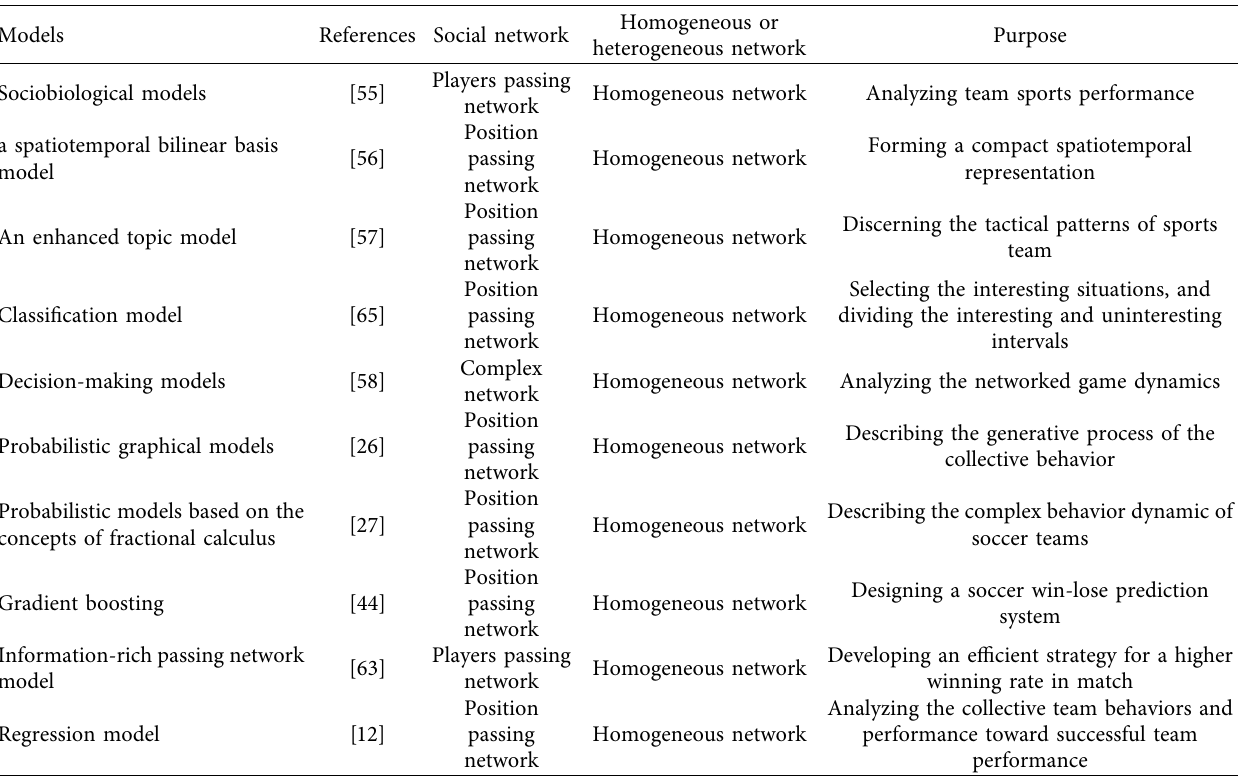
Figure 4: A framework for sports social network models. Table 3: Representative models for sports social network analysis from 2012 to